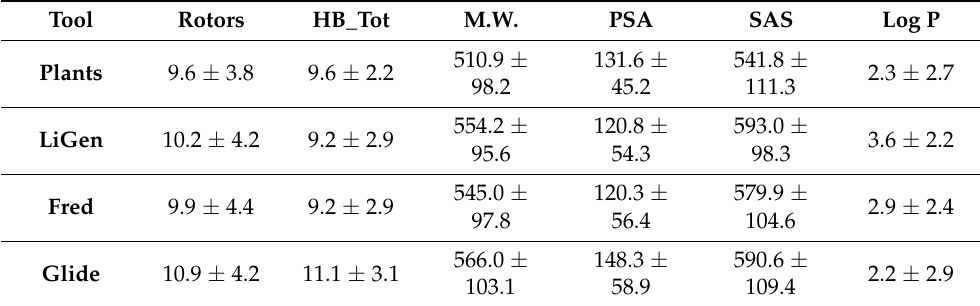
Table 7. Average values plus standard deviations for some key geometrical and physicochemical properties as computed by considering the Top 500 molecules of each